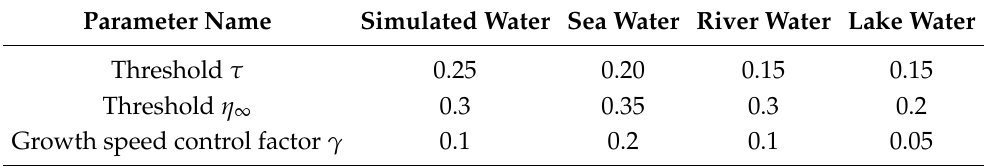
Table 2. The hyperparameters settings for different datasets.